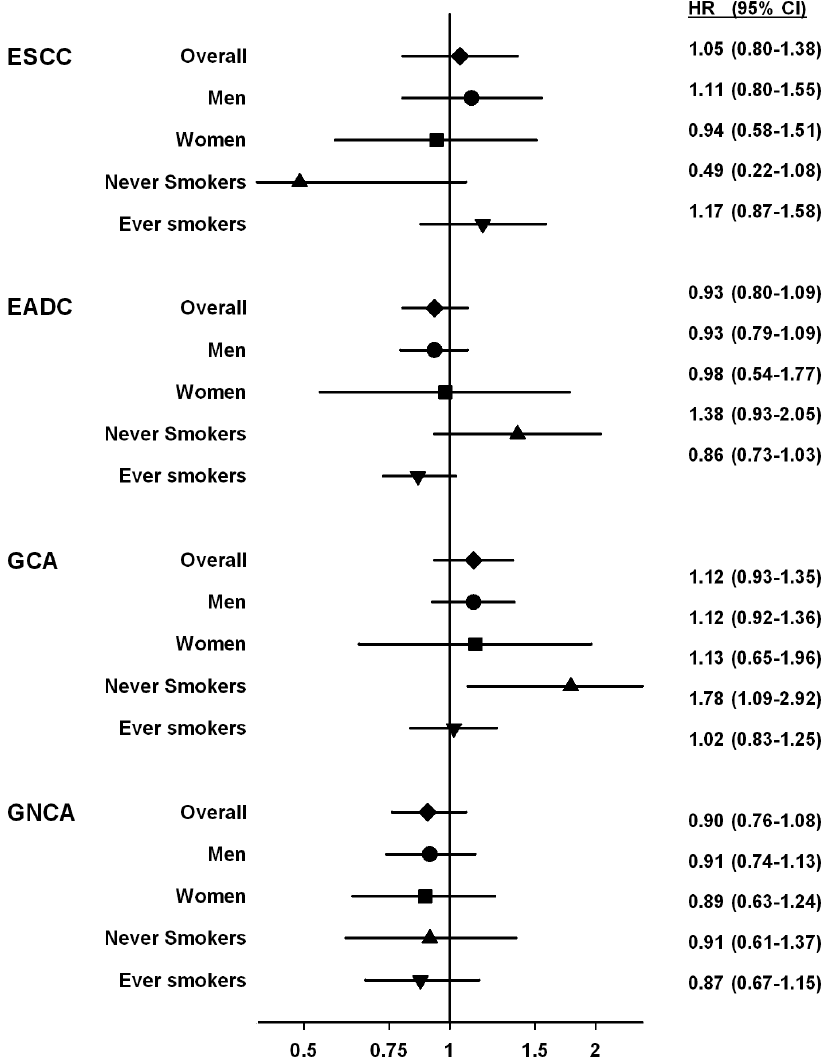
Figure 1. Adjusted hazard ratios (HR) and 95% confidence intervals (CI) for any use of multivitamin supplements for four upper gastrointestinal cancers stratified by sex or smoking in the NIH-AARP Diet and Health Study cohort. Of the eight tests, only smoking status for esophageal adenocarcinoma showed significant effect modification (P=0.022), but the estimates in both strata have confidence intervals that include 1.